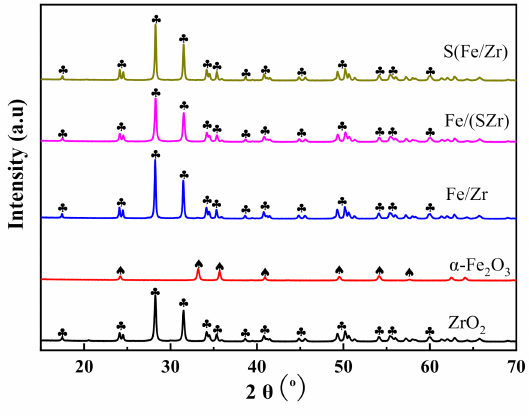
Figure 2. XRD patterns of di ff erent iron-based catalysts.